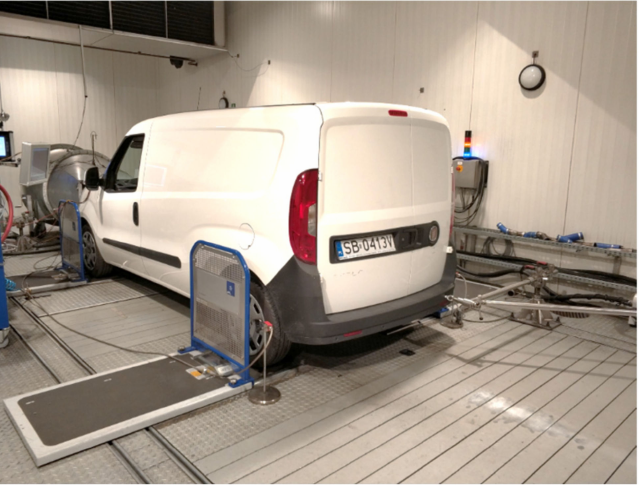
Figure 6. Test vehicle set up in the laboratory on the chassis dynamometer within the climatic chamber.